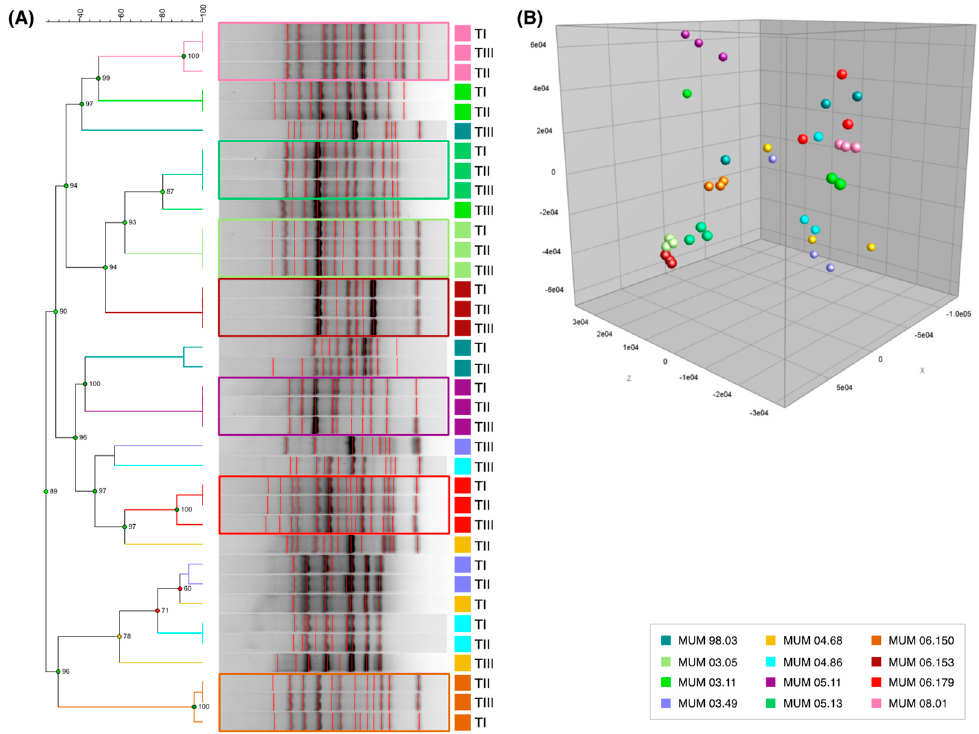
Figure 4. M13 fingerprinting results with data from three preservation time points. TI—before preservation; TII—2 weeks of accelerated storage; and TIII—4 weeks of accelerated storage. ( A ) dendrogram based on Dice coe ffi cient and UPGMA. Cophenetic correlation coe ffi cient values associated with the branches are shown in the nodes. Coloured boxes indicate strains where the three-time points cluster together. ( B ) principal component analysis plot.